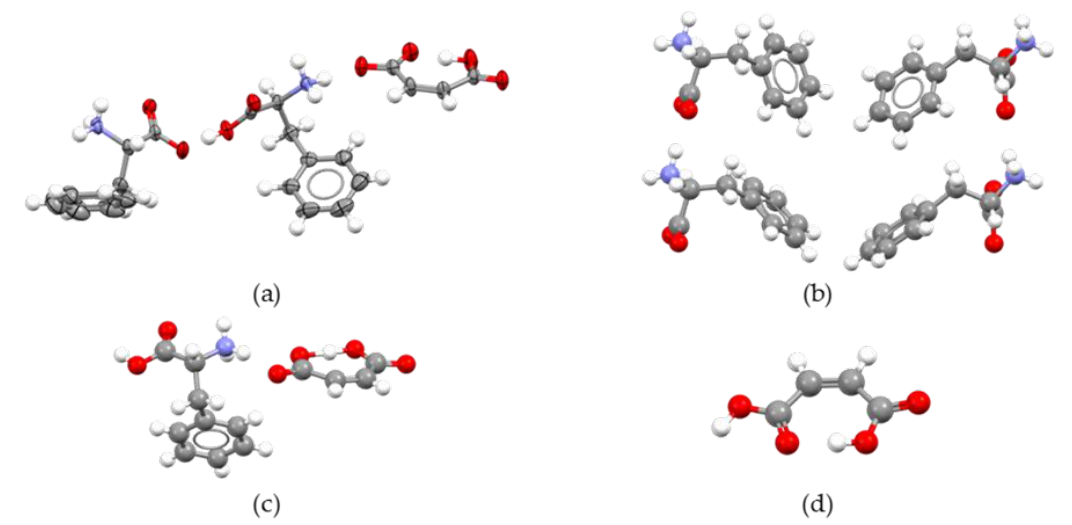
Figure 1. Mercury 3.10.1 (Build 290188) [41] diagram of the asymmetric units of: ( a ) MA:Phe 2 (this work, the thermal ellipsoids of C, N, and O atoms were drawn at 50% probability); ( b ) L-phenylalanine (polymorph I, CSD Refcode: QQQAUJ06 [28,38]); ( c ) MA:Phe (CSD Refcode: EDAXIQ) [28,40]); ( d ) maleic acid (polymorph I, CSD Refcode: MALIAC11, [28,37]).